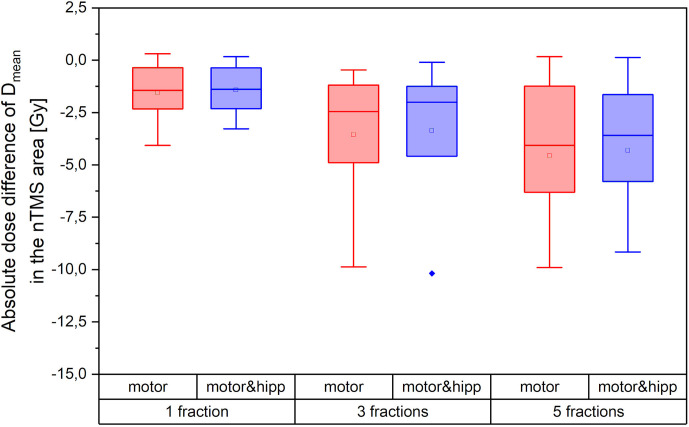
Absolute dose sparing in the navigated transcranial magnetic stimulation (nTMS) area (mean dose) achieved by the reoptimized plans as a function of fractionation regime.